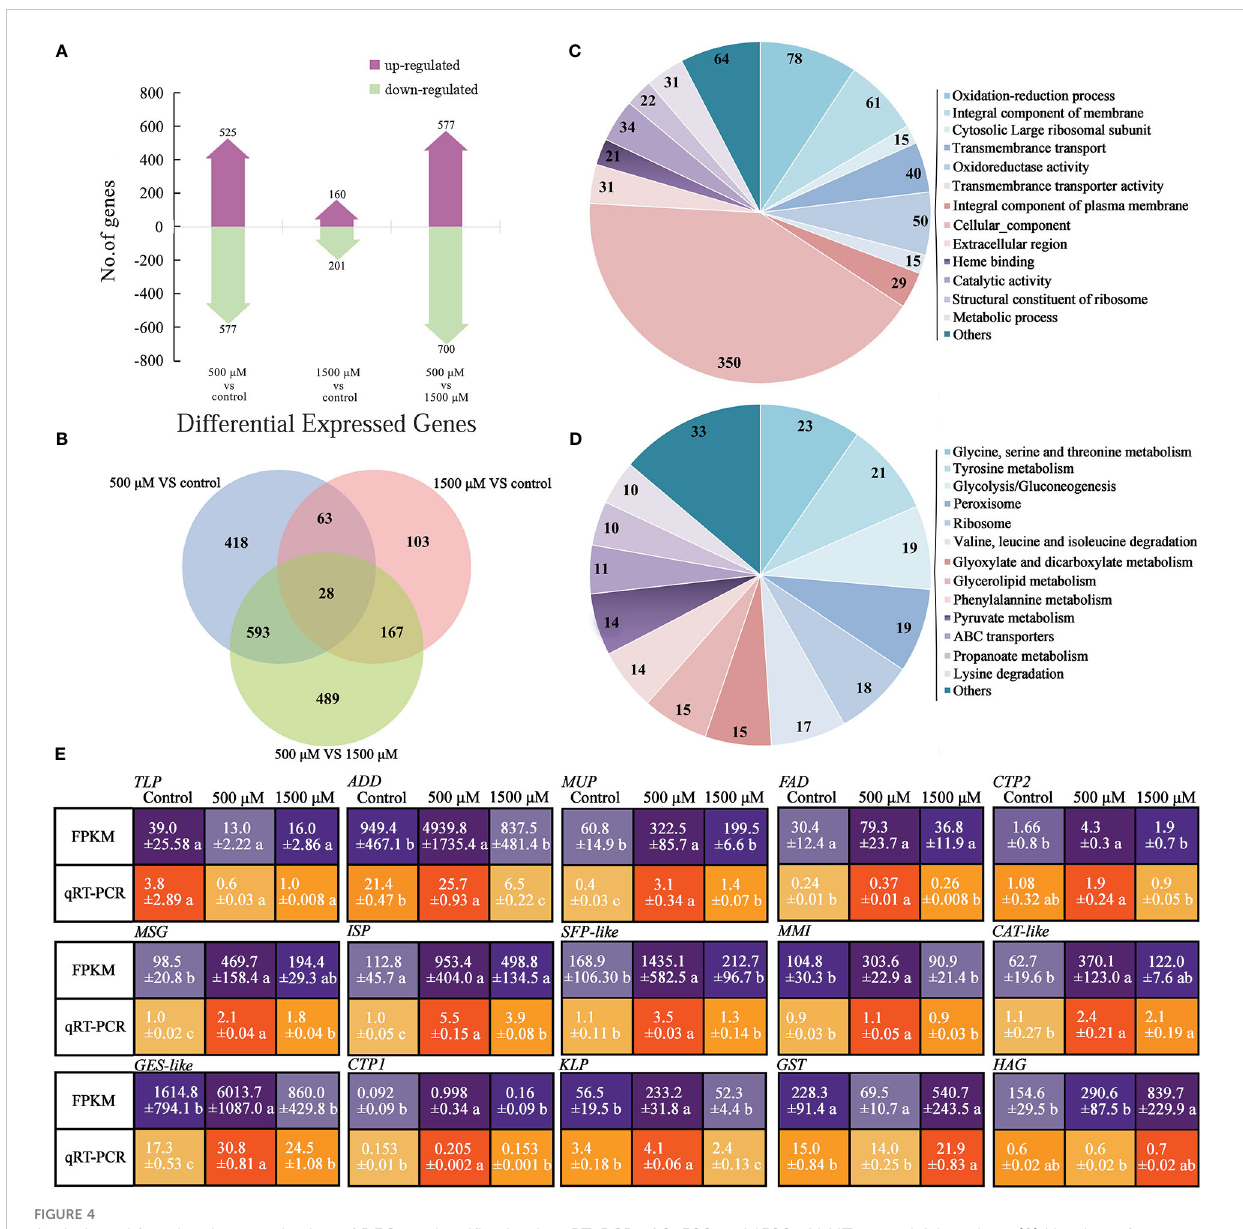
FIGURE 4 Analysis and functional categorization of DEGs and veri fi cation by qRT-PCR of 0, 500 and 1500 m M MT treated A brassicae . (A) Number of genes up- and down-regulated in contrast sets of 500 m M MT treated group VS control, 1500 m M MT treated group VS control, and 1500 m M VS 500 m M MT treated groups; (B) Comparison of the number of DEGs for different comparisons; (C, D) Main function of DEGs annotated by GO classi fi cation and KEGG pathway analysis; (E) Veri fi cation of selected DEGs from RNA-seq using qRT-PCR. The relative expression level of a gene in was determined using a 2 - △△ Ct method, and signi fi cant difference at P < 0.05 compared to the control is indicated by lowercase